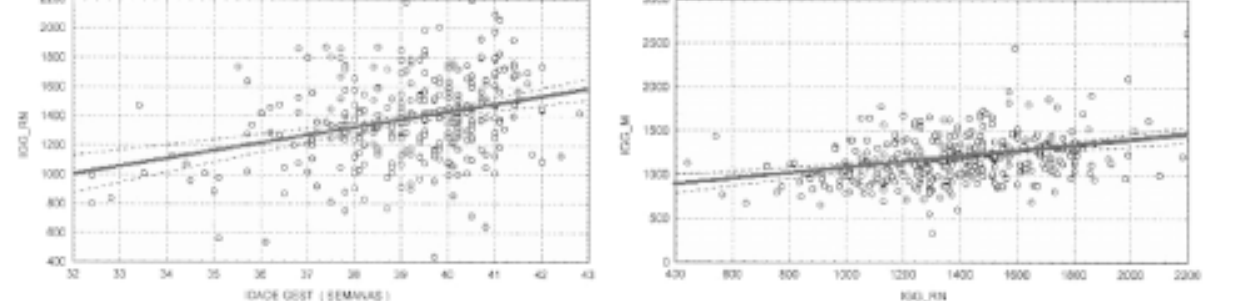
FIGURA 1 - Reta de regressªo e equa(cid:231)ªo correspondente de IgG do RN com a idade gestacional